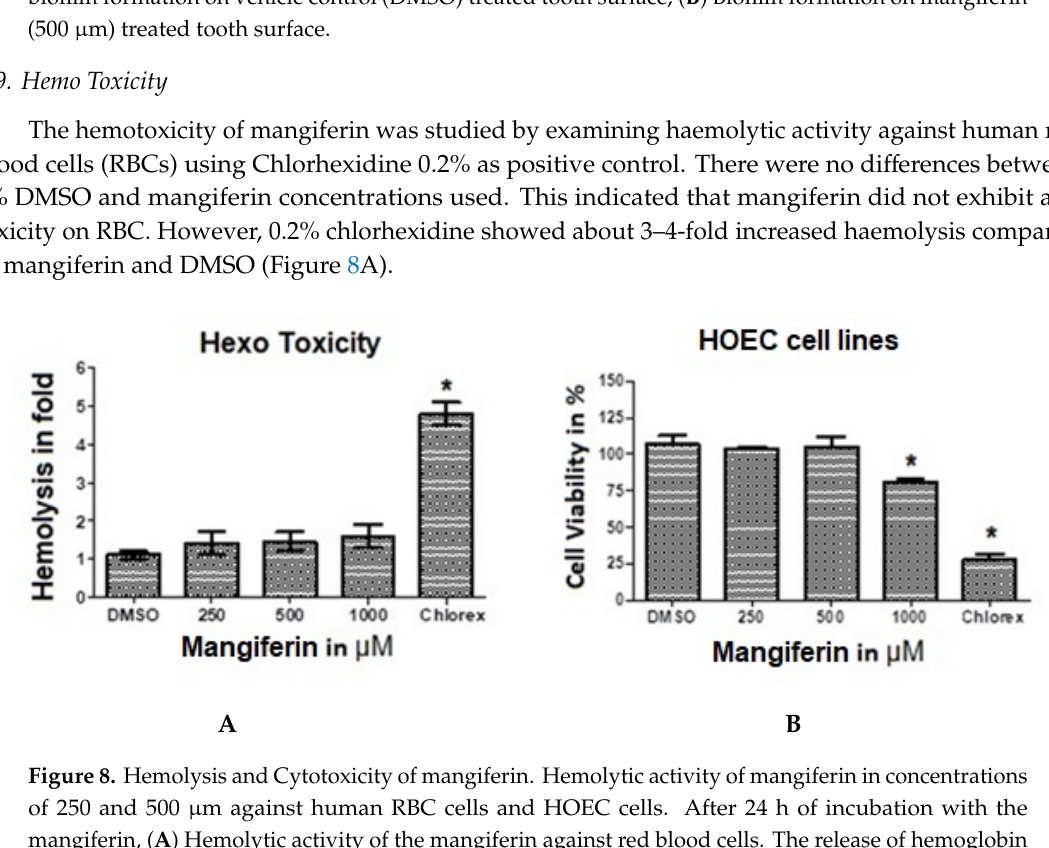
Figure 7. SEM images showing biofilm of S. mutans on control and mangiferin treated tooth. ( A ) The